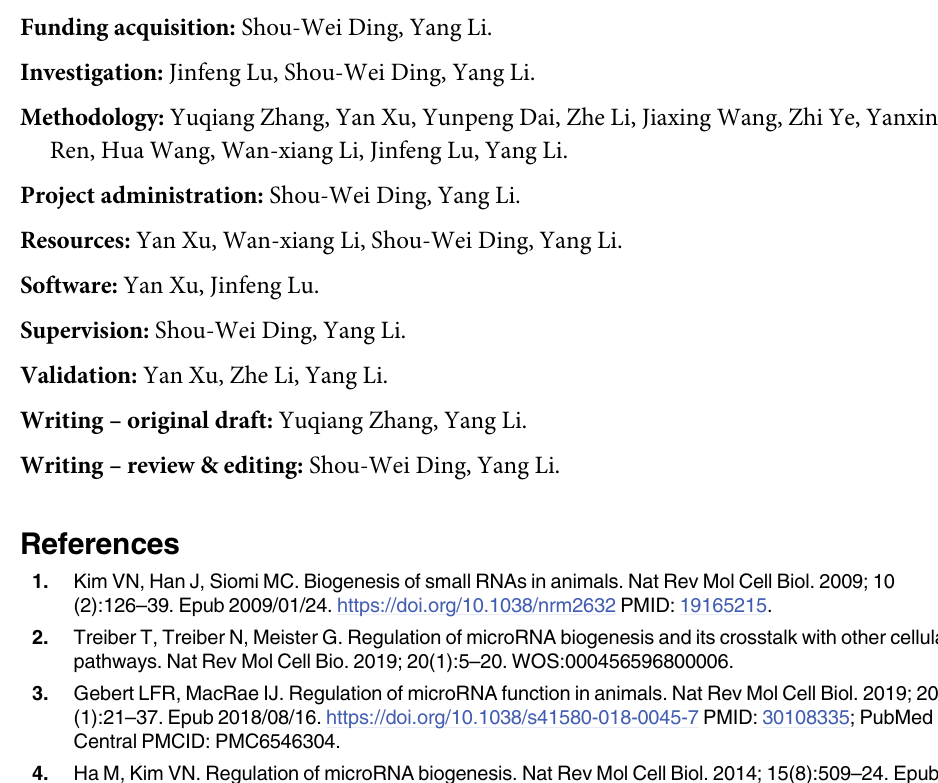
S1 Table. Contents and properties of the small RNA libraries sequenced. S2 Table. Primers, Related to Experimental